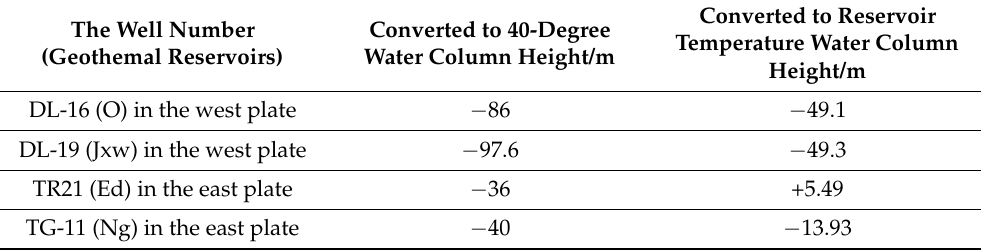
Table 2. Correlation of water column height at the same geothermal reservoir depth located at the east and west plate of the Cangdong